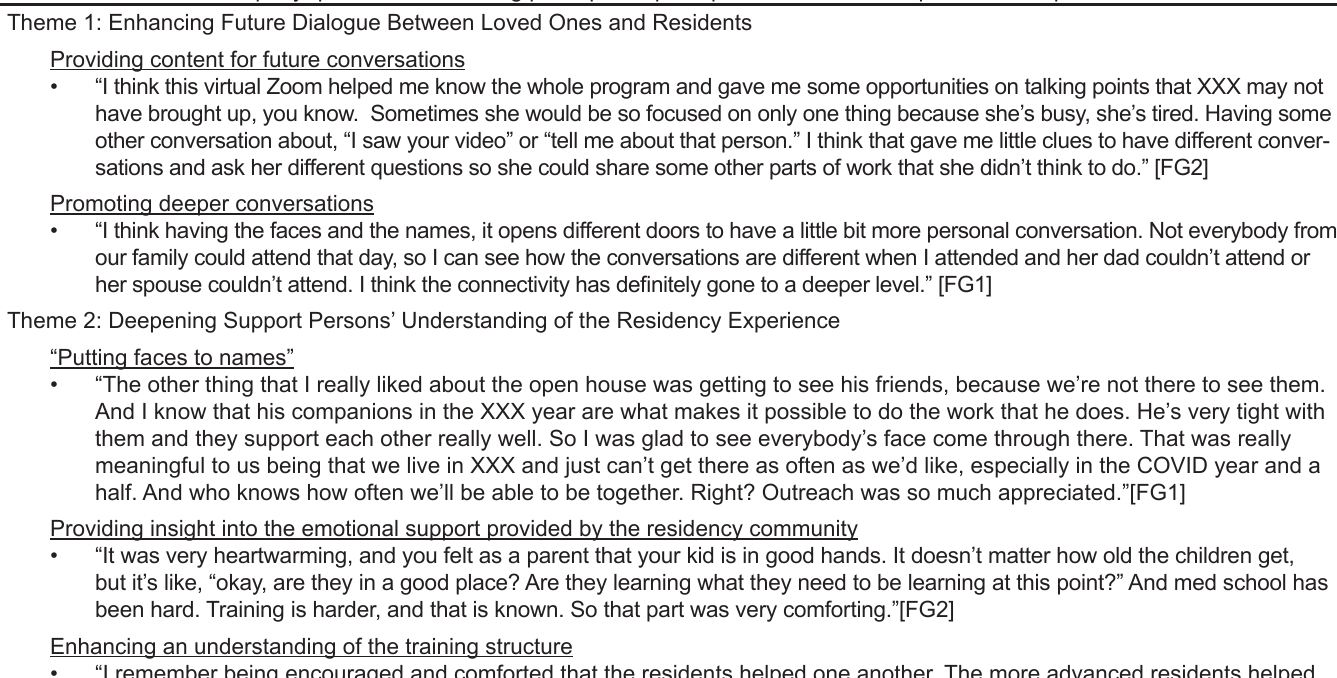
Table. Themes with exemplary quotations describing participants’ perceptions of the virtual open house